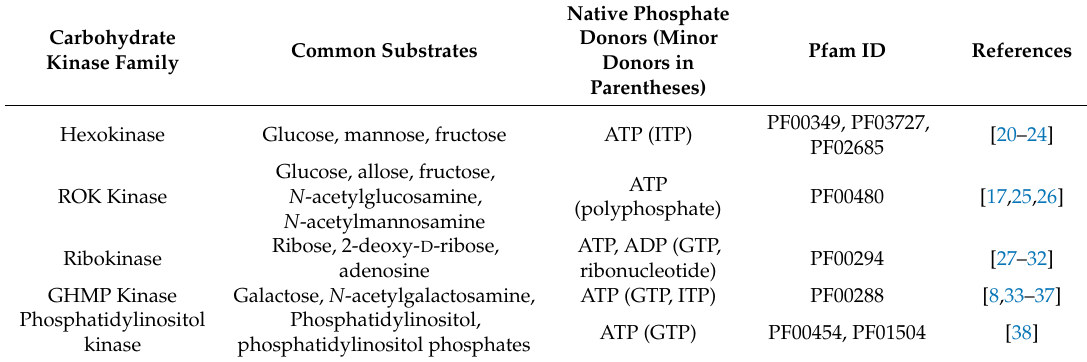
Table 1. Overview of the carbohydrate kinase